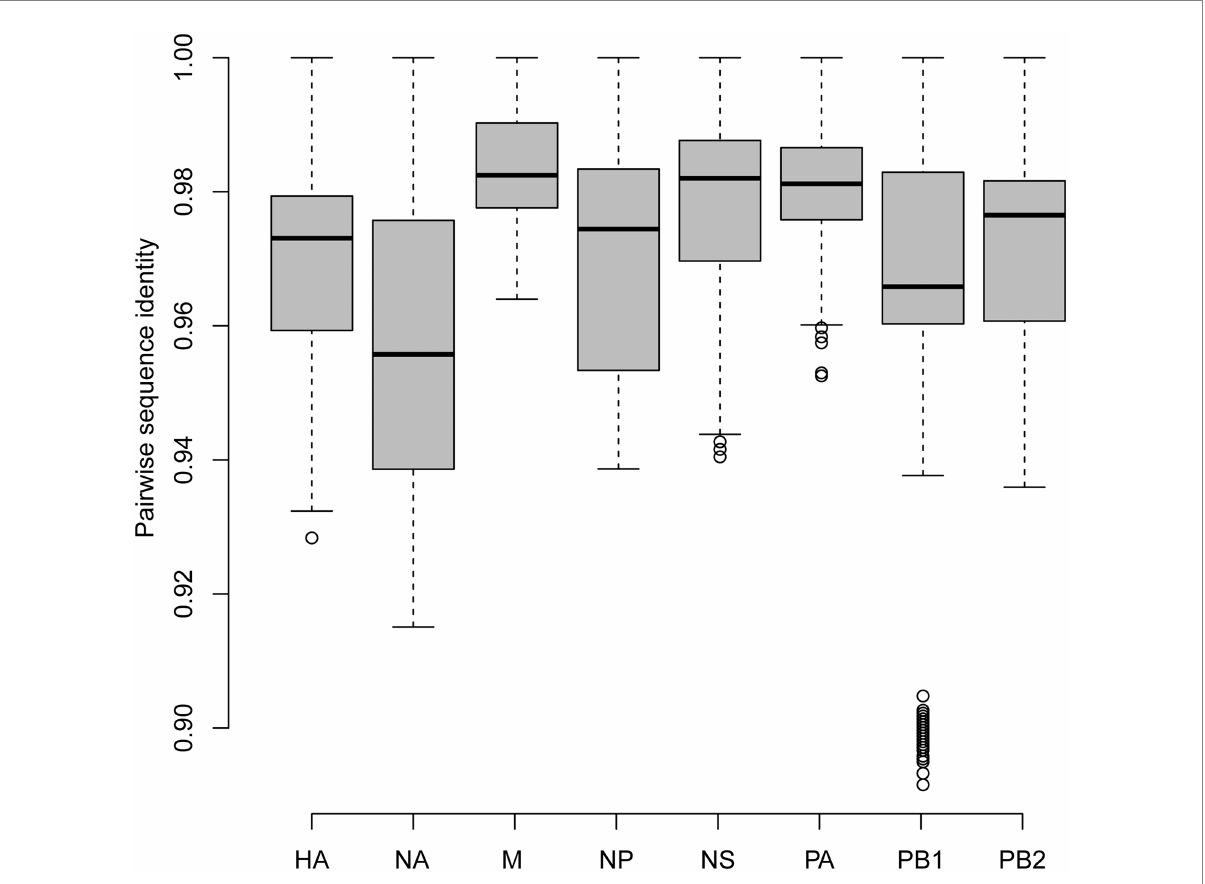
FIGURE 2 Pairwise sequence identities of each segment between newly sequenced H9N2